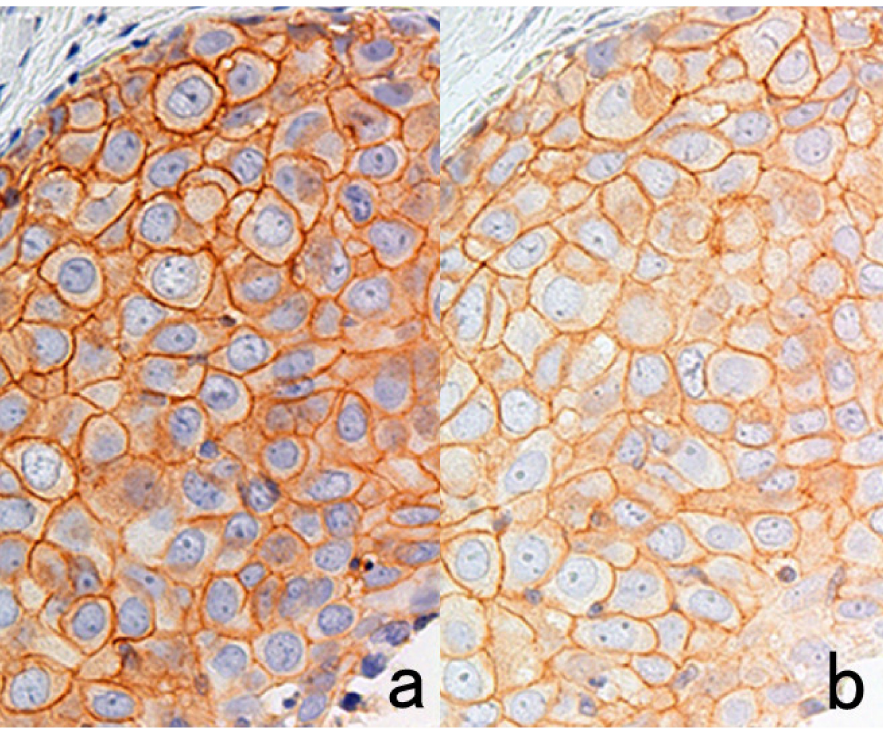
Figure 26. Weakened HER2 immunoreactivity in breast cancer cells by prolonged drying of unstained sections. Drying in an incubator at 40 ◦ C for 1 h ( a ) and for 3 days ( b ). The intensity of HER2 immunostaining is considerably weakened after prolonged drying in an incubator over a